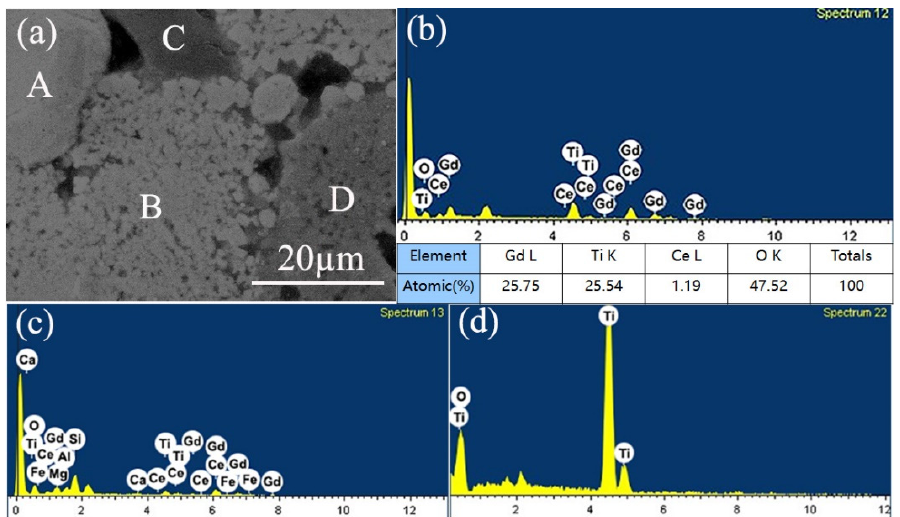
Figure 6. Energy dispersive X-ray spectroscopy (EDX) elemental spotting analysis: ( a ) Representative SEM image of the Cu-20 sample, ( b ) EDX spectrum and elemental composition of the labeled “B” area in ( a ), ( c ) EDX spectrum of region C in ( a ), ( d ) EDX spectrum of region D in ( a ).